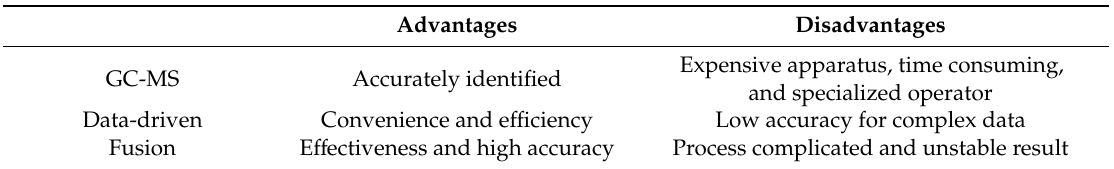
Table 1. The advantages and disadvantages of each method of identifying components in the gas